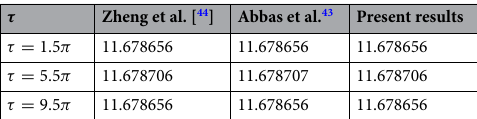
1 , M 12, Nr 0, Rb 0. = = = =